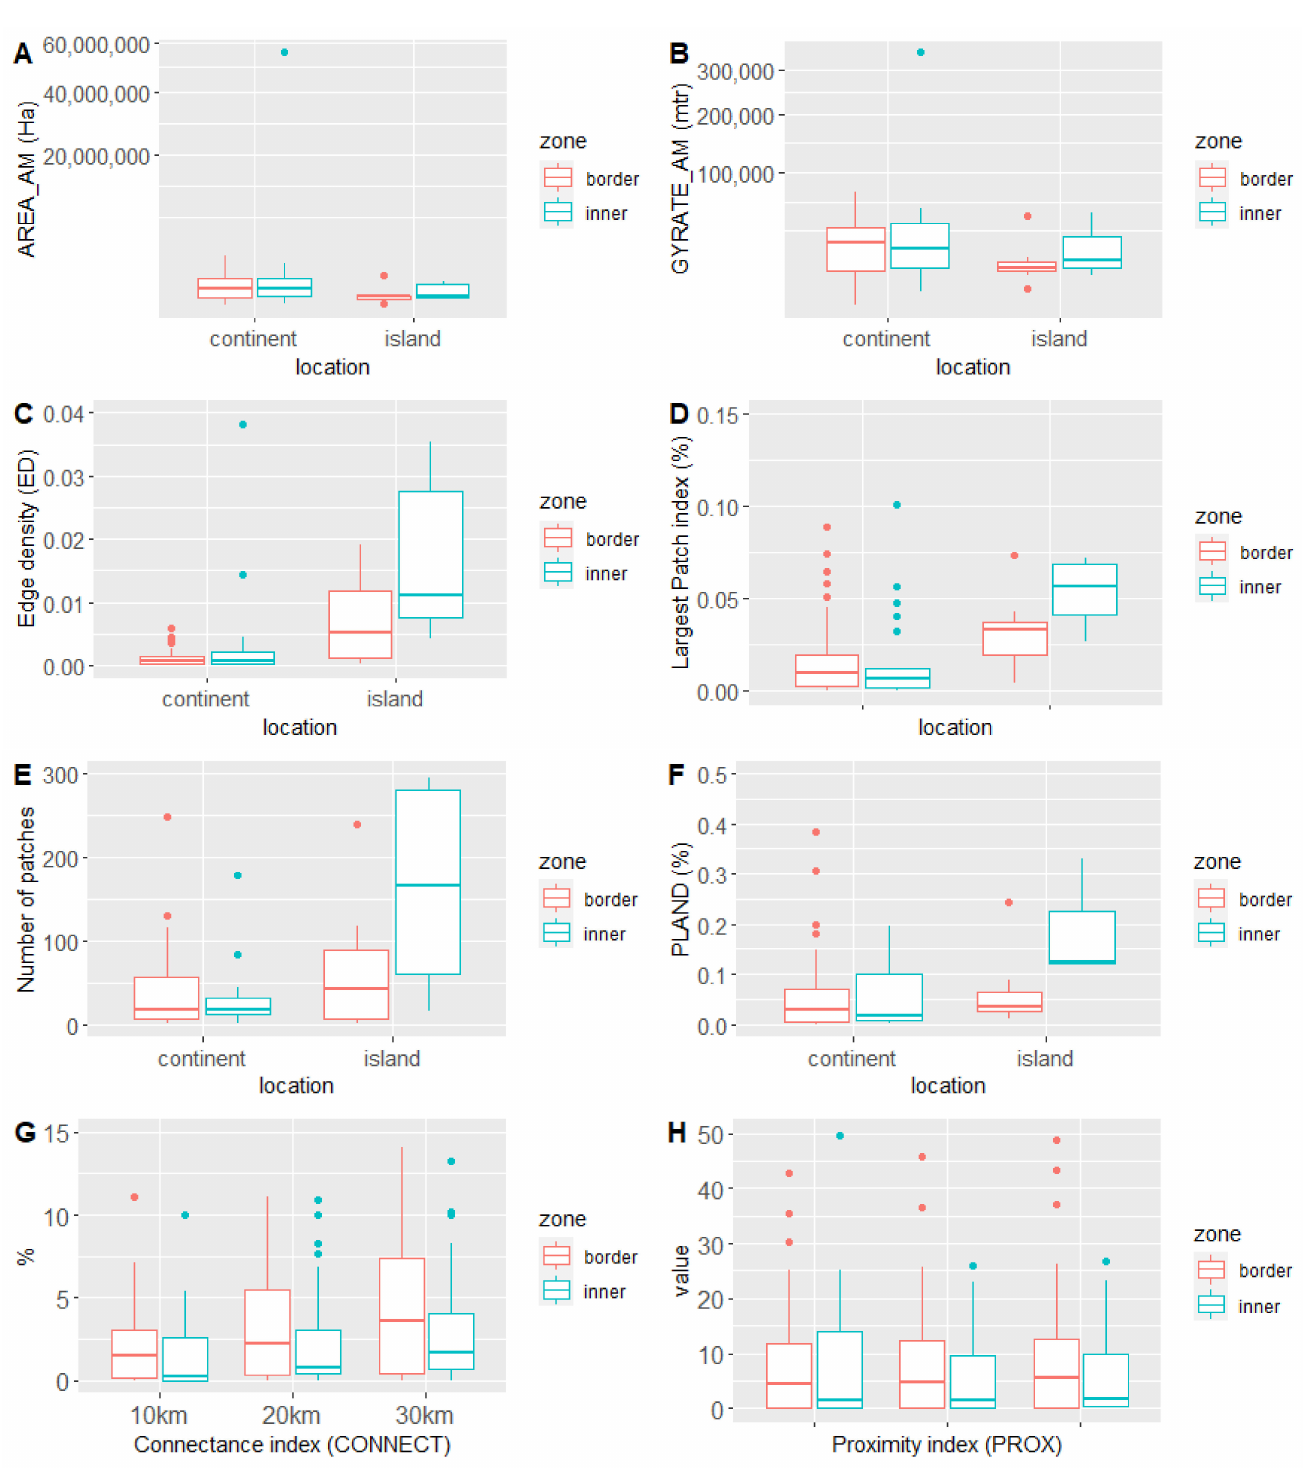
Figure 3. Comparison of eight different connectivity metrics at zonal scale (Asian countries borders and the internal zones; ( A – F ), and geo-graphic scales (Asian islands and continental areas; ( G , H ). Dots represent data point that differs significantly from other